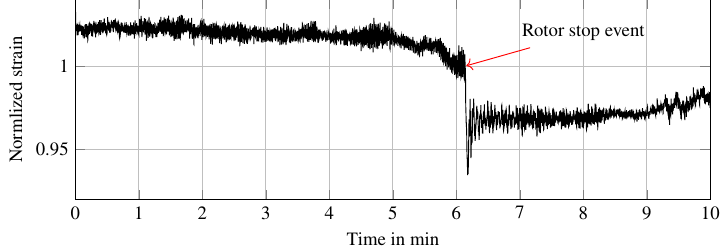
Figure 6. 10min time series of a rotor stop event around rated wind speed: Normalized measured strains (FBG) versus